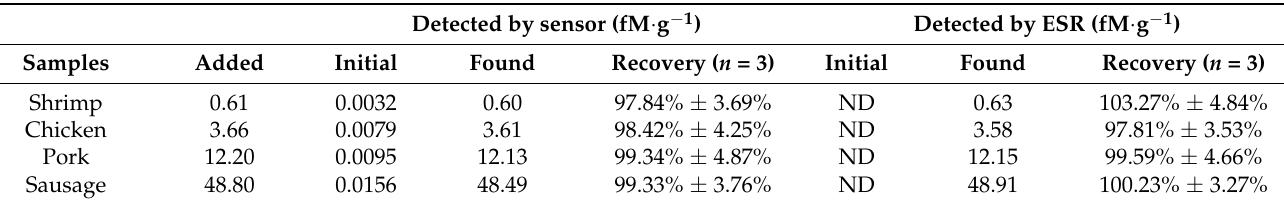
Table 2. Comparison of two methods obtained with real meat